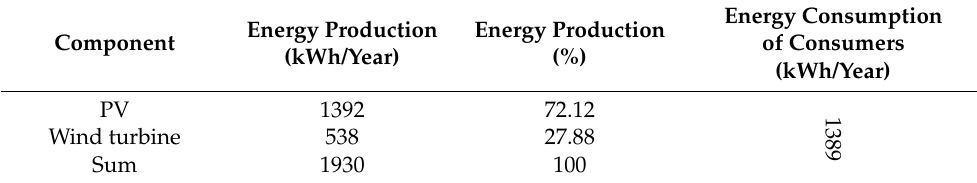
Table 14. The annual production for the third case using iHOGA simulator.